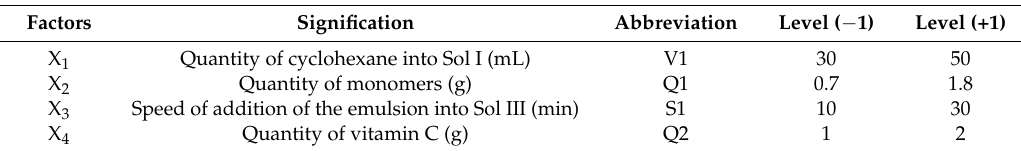
Table 1. Experimental factors and